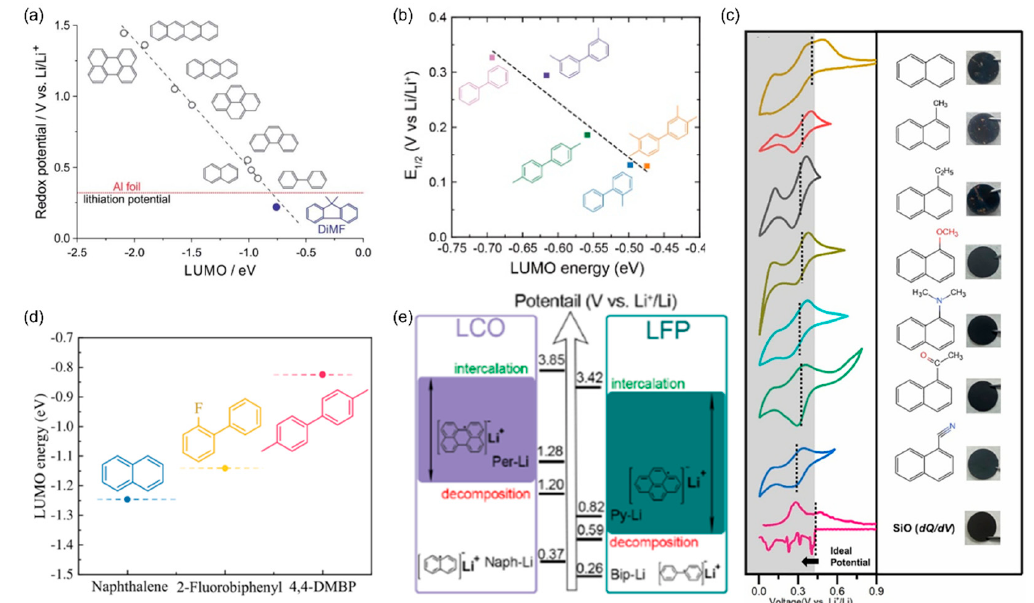
Figure 4. ( a ) The correlation between the redox potentials and LUMO energies of PAH molecules. Reproduced with permission from ref. [40]. Copyright 2020, The Royal Society of Chemistry. ( b ) The correlation between the redox potentials (E 1/2 ) and LUMO energies of BP derivatives. Reproduced with permission from ref. [32]. Copyright 2020, Wiley-VCH. ( c ) Cyclic voltammograms for Li-Naph derivatives in 1.0 M LiPF 6 /THF, differential capacity curves for the SiO electrode, and photos of the prelithiated SiO electrodes immersed in 0.2 M Li-Naph derivative systems for 2 h. Reproduced with permission from ref. [53]. Copyright 2022, Elsevier. ( d ) LUMO energies of PAH derivatives. Reproduced with permission from ref. [54]. Copyright 2021, ACS Publications. ( e ) The redox potentials of various Li-PAH complexes in comparison with the intercalation/decomposition potentials of LFP and LCO cathodes. Reproduced with permission from ref. [52]. Copyright 2021, ACS Publications.